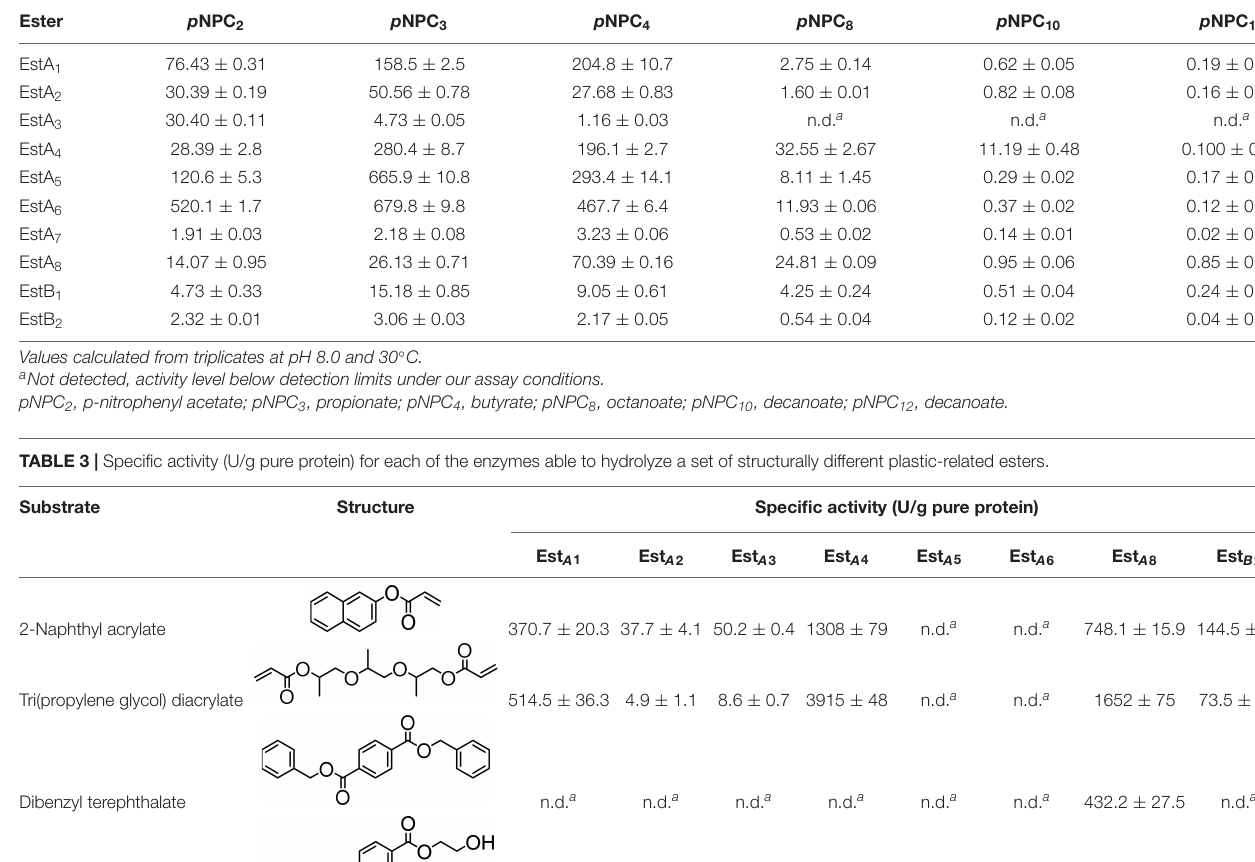
Assays were performed in triplicate with values for each of the replicates given in the table with standard deviation. Values calculated at pH 8.0 and 30 ◦ C. a Not detected, activity level below detection limits under our assay conditions. b Time course of the degradation shown in Supplementary Figure 3